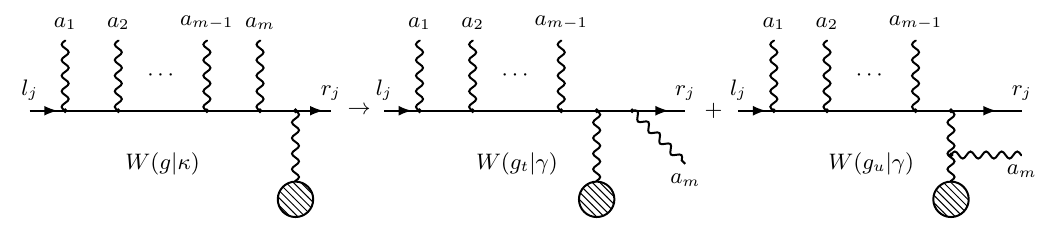
Figure 10 . A visualization of eq. (5.19), a key step to prove Lemma